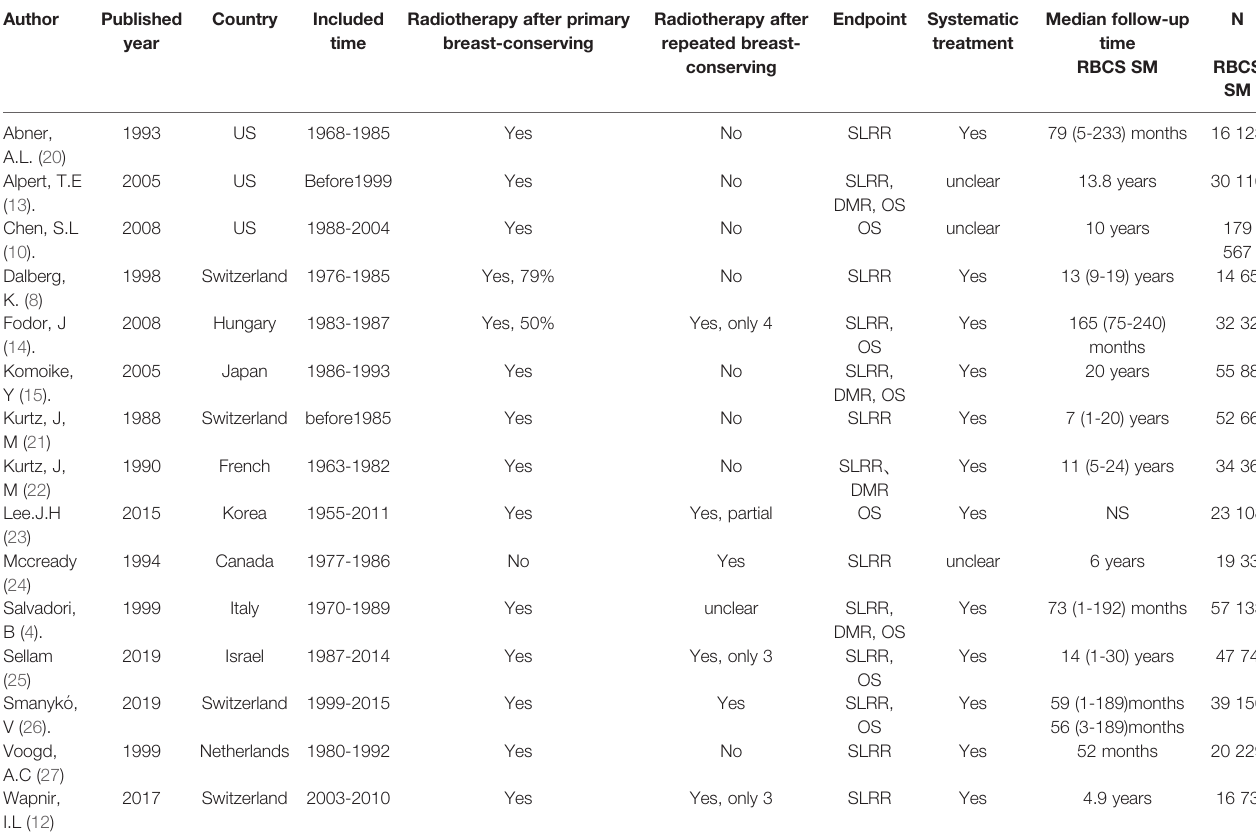
TABLE 1 | Characteristics of included studies.